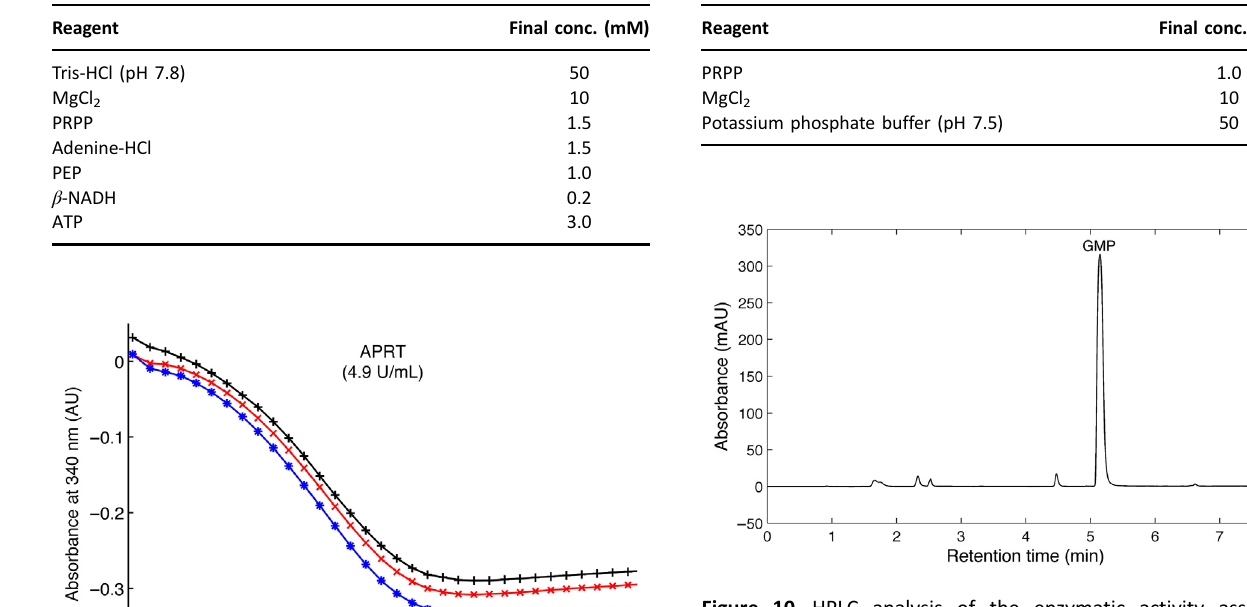
Figure 10. HPLC analysis of the enzymatic activity assay of XGPRT.